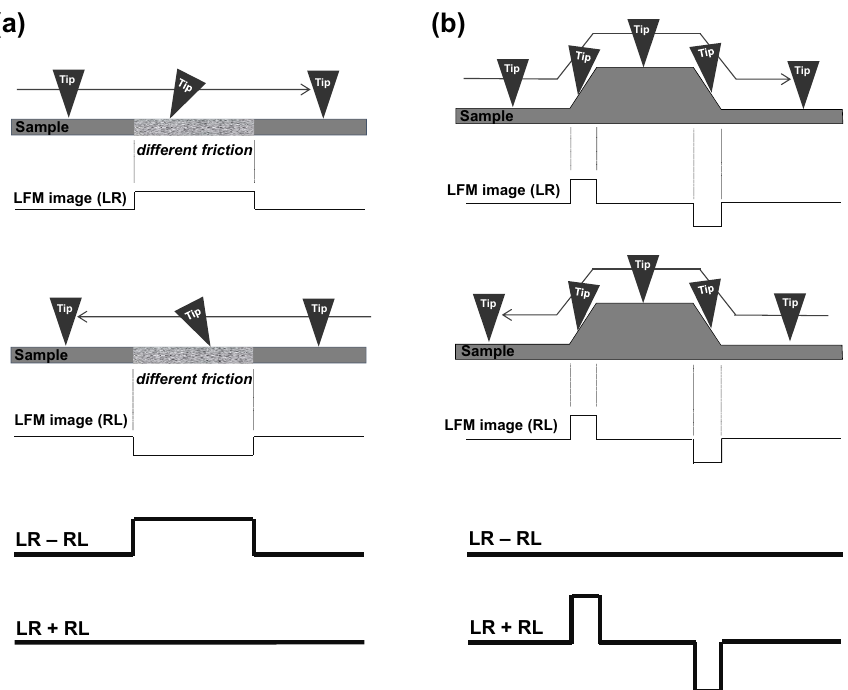
Figure 1. Schematics showing the principles of lateral force microscopy (LFM) imaging. The intensity of LFM during the imaging is brought about by the tip ( a ) moving over different regions of friction and ( b ) moving up from and down to different levels. LR, left-to-right; RL, right-to-left. LR − RL and LR + RL are the resulting images by subtracting and adding the LFM images,